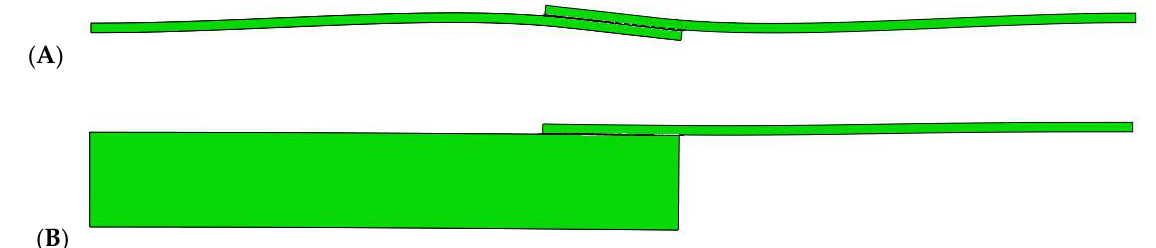
Figure 3. Deformation of single lap joints: ( A ) model 6 and ( B ) model 57.